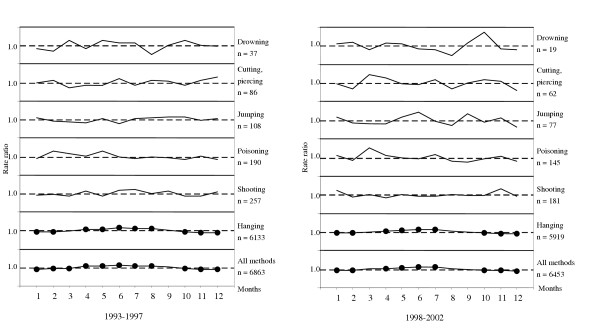
The monthly ratios of suicides by method among Lithuanian men. Statistically significant peaks are dark-dotted.